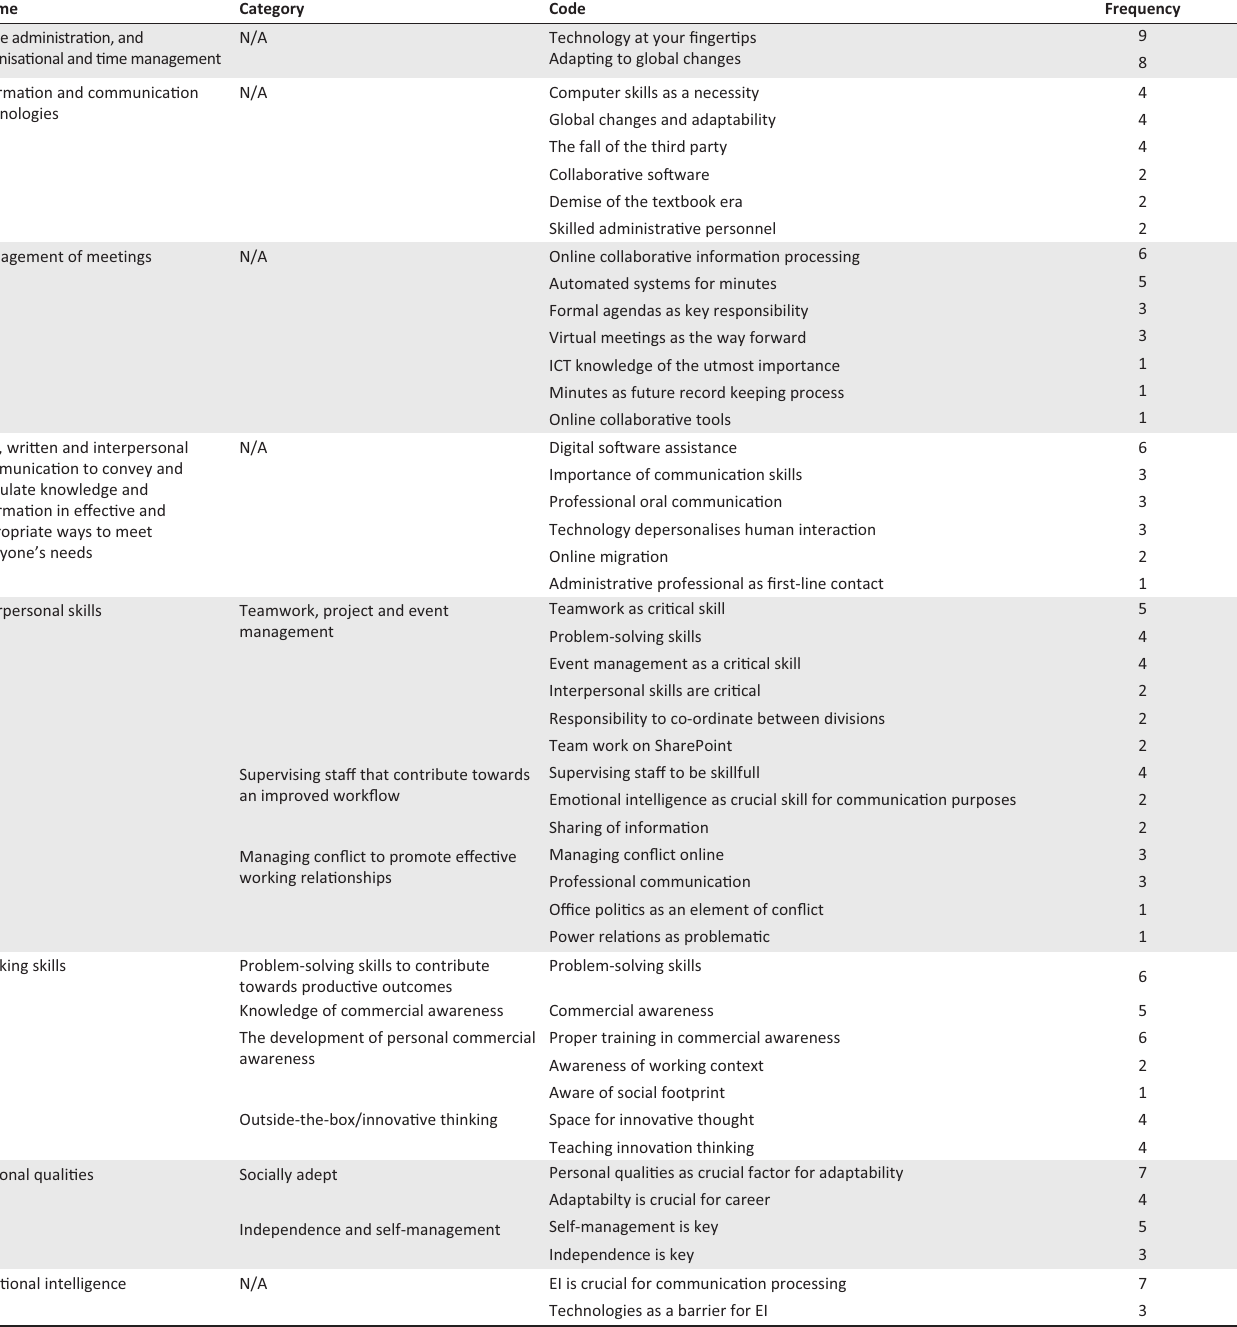
TABLE 5: Summary of frequency distribu(cid:13)on and